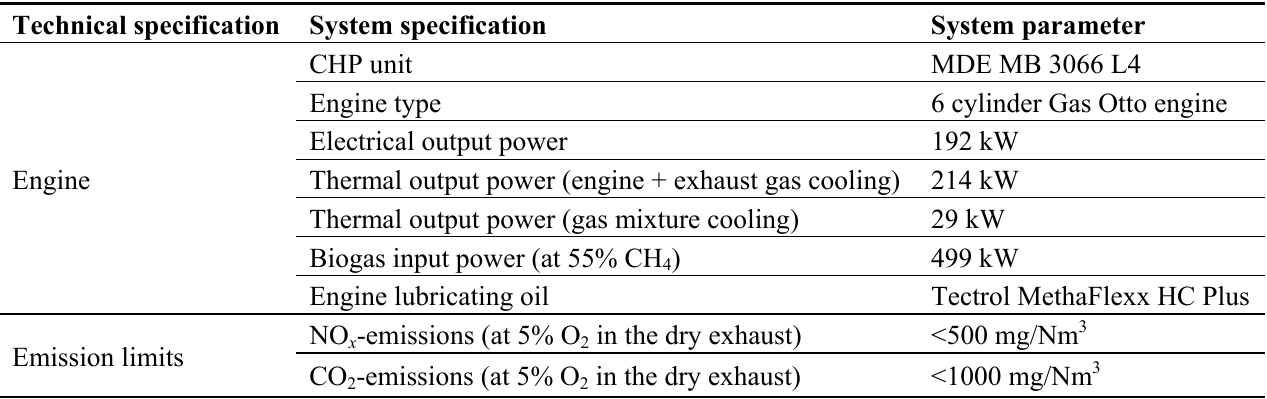
Table 2. Nominal data of the CHP unit at the “Unterer Lindenhof” research